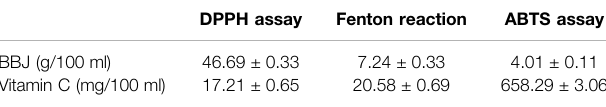
TABLE 2 | The antioxidant activity (IC 50 values) of BBJ and Vitamin C. DPPH assay Fenton reaction